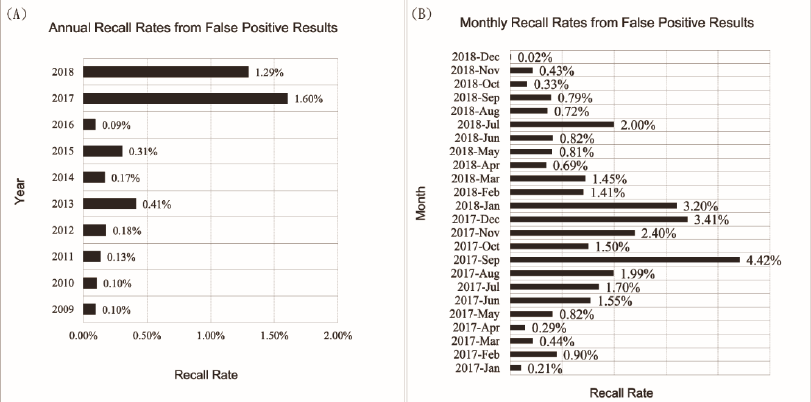
Figure 1. Recall rates of neonatal hyperphenylalaninemia (HPA) screening resulting from false positive results in Tianjin, China. ( A ) Annual recall rates due to false positive cases, numbers calculated by dividing total number of infants screened each year with number of infants recalled to the laboratory whose confirmatory tests were negative. ( B ) Monthly recall rate for 2017 and 2018 calculated in the same way, showing the gradual decrease of recall rate after the contaminated collection devices were replaced with new collection devices starting in January of